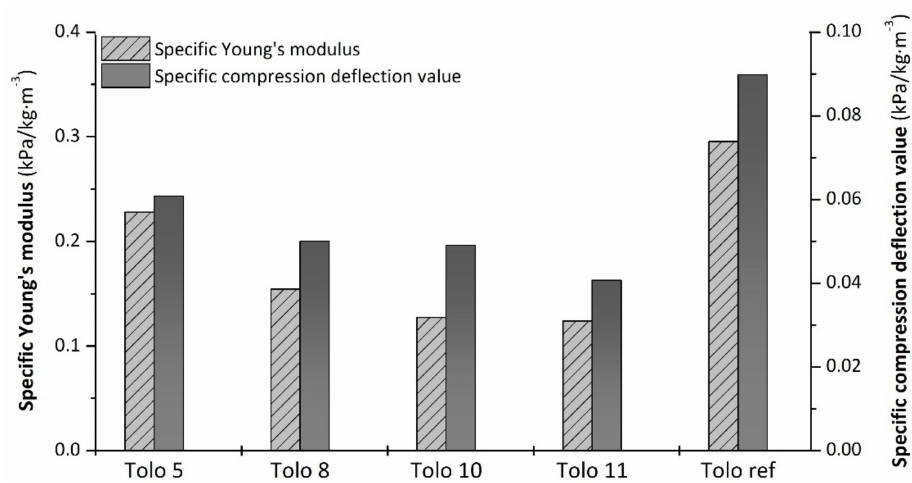
Figure 13. Specific compression properties of PU